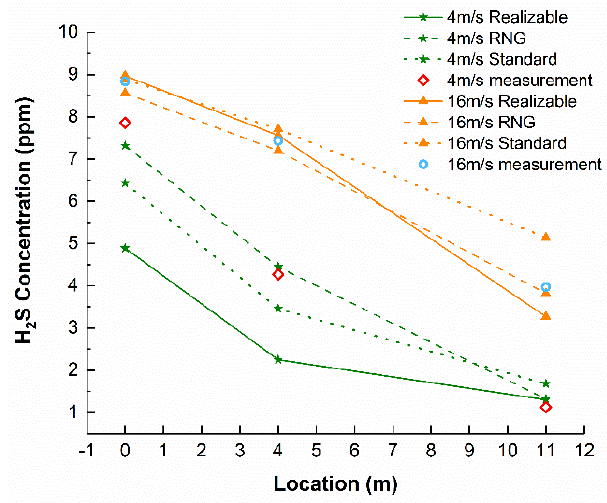
Figure 3. Validation of Realizable, RNG, and Standard model.